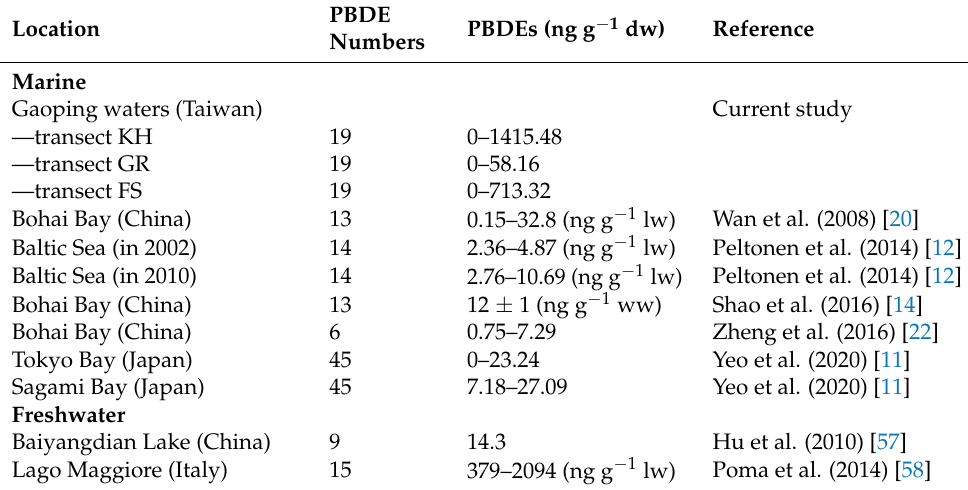
Table 4. PBDE concentrations in zooplankton samples in other marine environments. KH: Kaohsiung Harbor; GR: Gaoping River estuary; FS: Fengshan